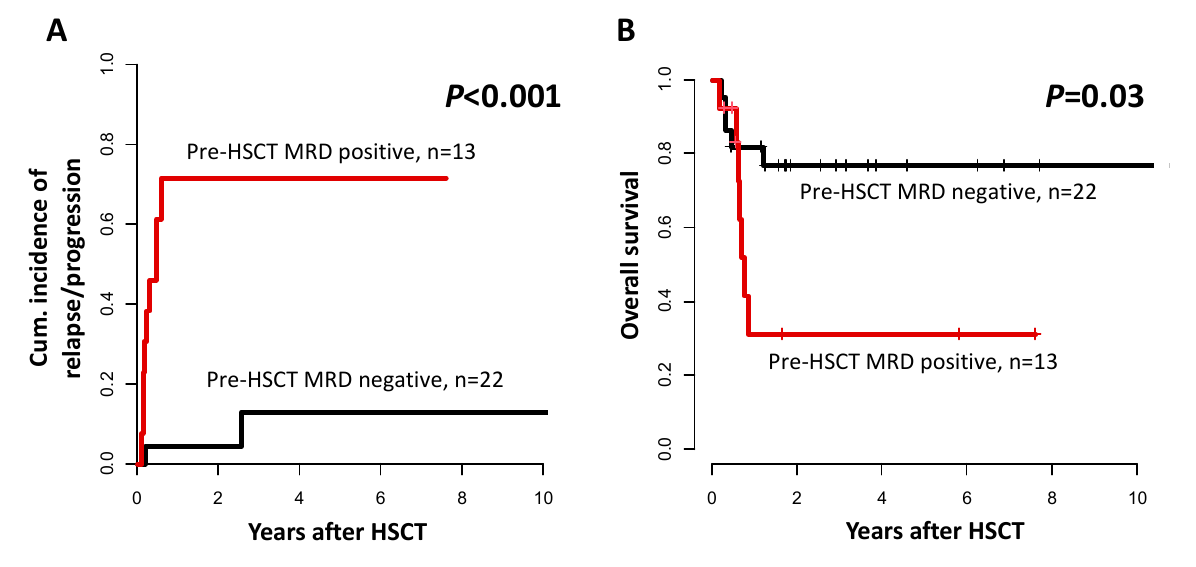
Figure 4. Outcomes according to NPM1 , and FLT3 -TKD MRD status prior to allogeneic HSCT in patients transplanted in remission ( n = 35). ( A ) Cumulative incidence of relapse/progression and ( B ) Overall survival.